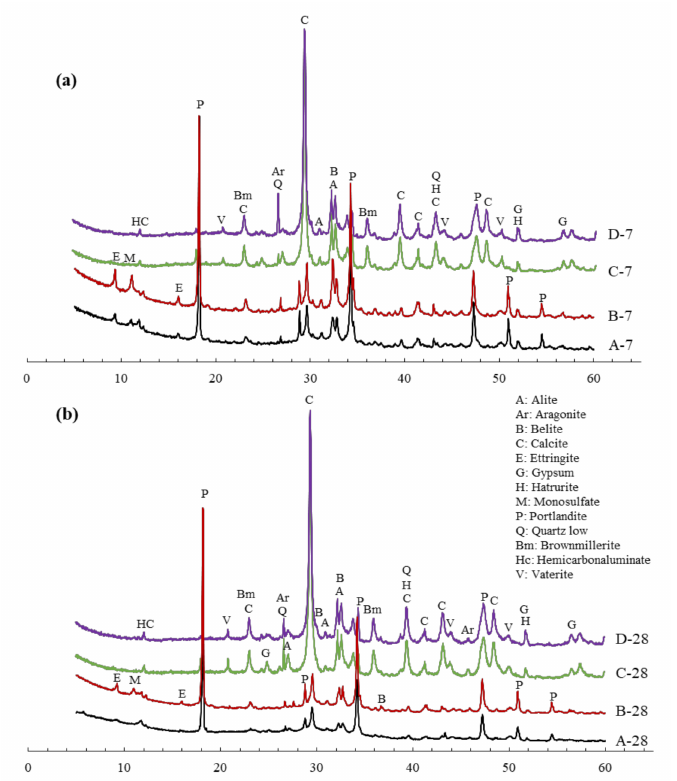
Figure 5. X-ray diffractometer (XRD) analysis of paste specimens after ( a ) 7 and ( b ) 28 days.